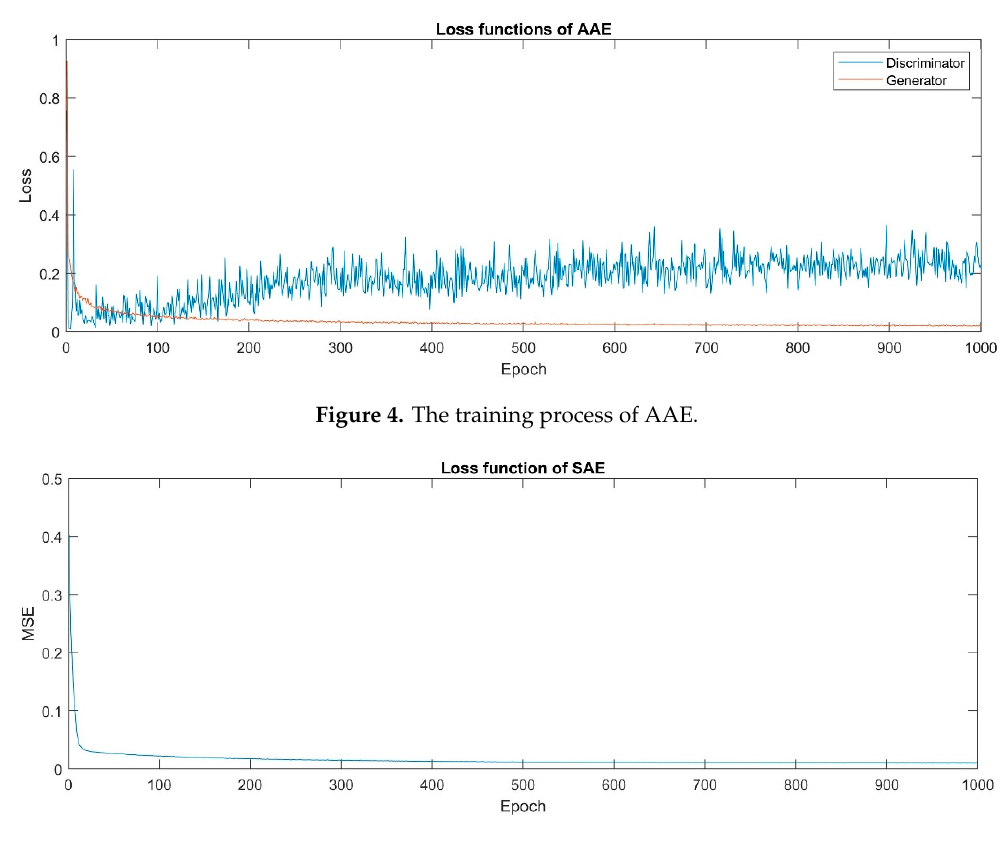
Figure 5. The training process of SAE. Table 1. The deep structure of